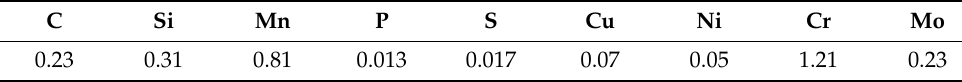
Table 1. Chemical composition of JIS SCM420H (wt.%).